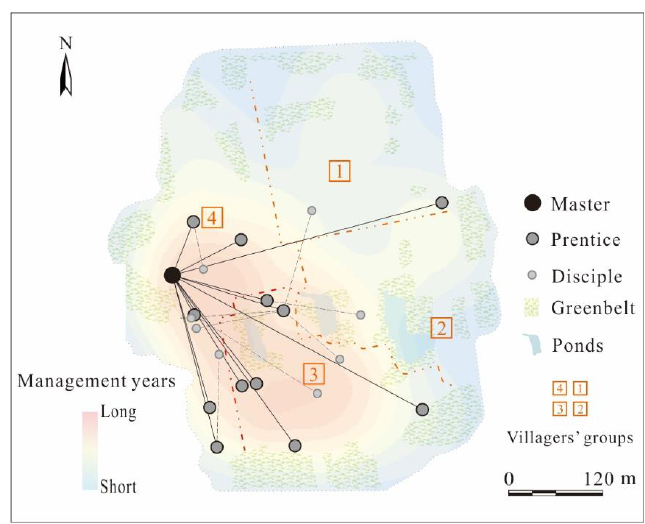
Figure 3. The main networks of skill learning in Village